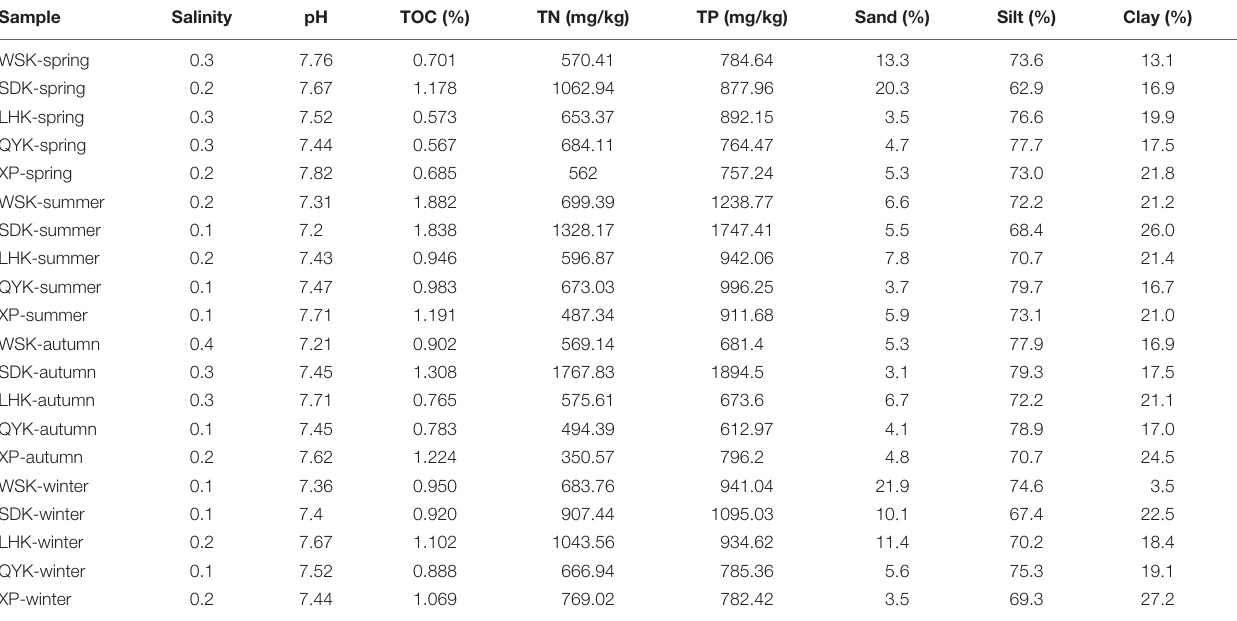
TABLE 1 | Physicochemical properties of intertidal sediments along the Yangtze River estuary at different seasons. Sample Salinity